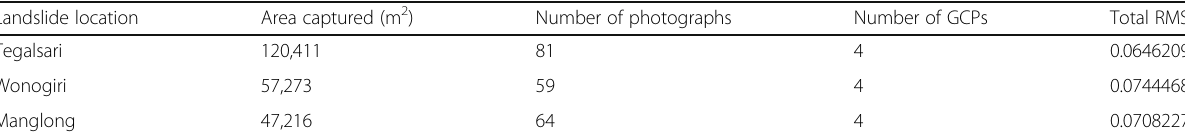
Table 2 UAV flight information